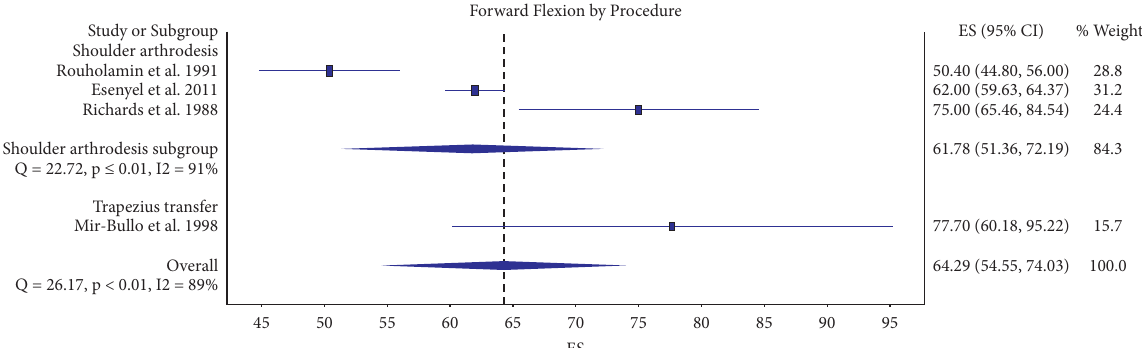
Figure 5: Forest plot illustrating active shoulder forward flexion for shoulder arthrodesis versus upper trapezius transfer. Study or Subgroup Shoulder arthrodesis